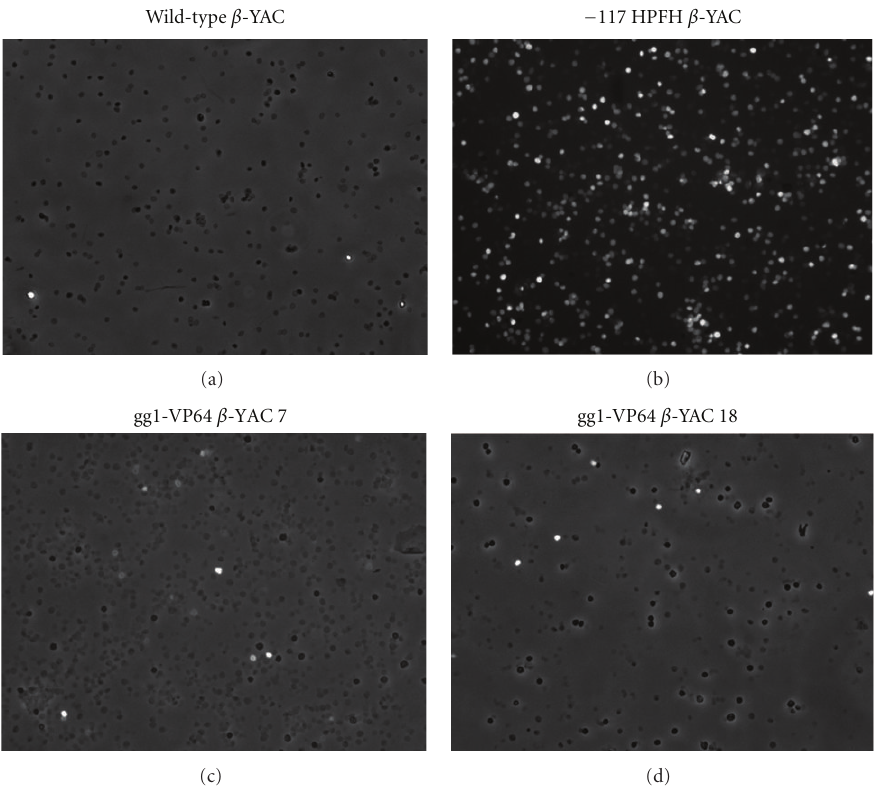
Figure 4: Staining of gg1-VP64 β -YAC bigenic mouse adult blood with anti-human hemoglobin F-FITC-conjugated antibody. Processing of peripheral blood cytospins was performed as described in the Materials and Methods section. (a) Wild-type β -YAC; (b) − 117 Greek HPFH β -YAC; (c) gg1-VP64 β -YAC 7; (d) gg1-VP64 β -YAC 18.